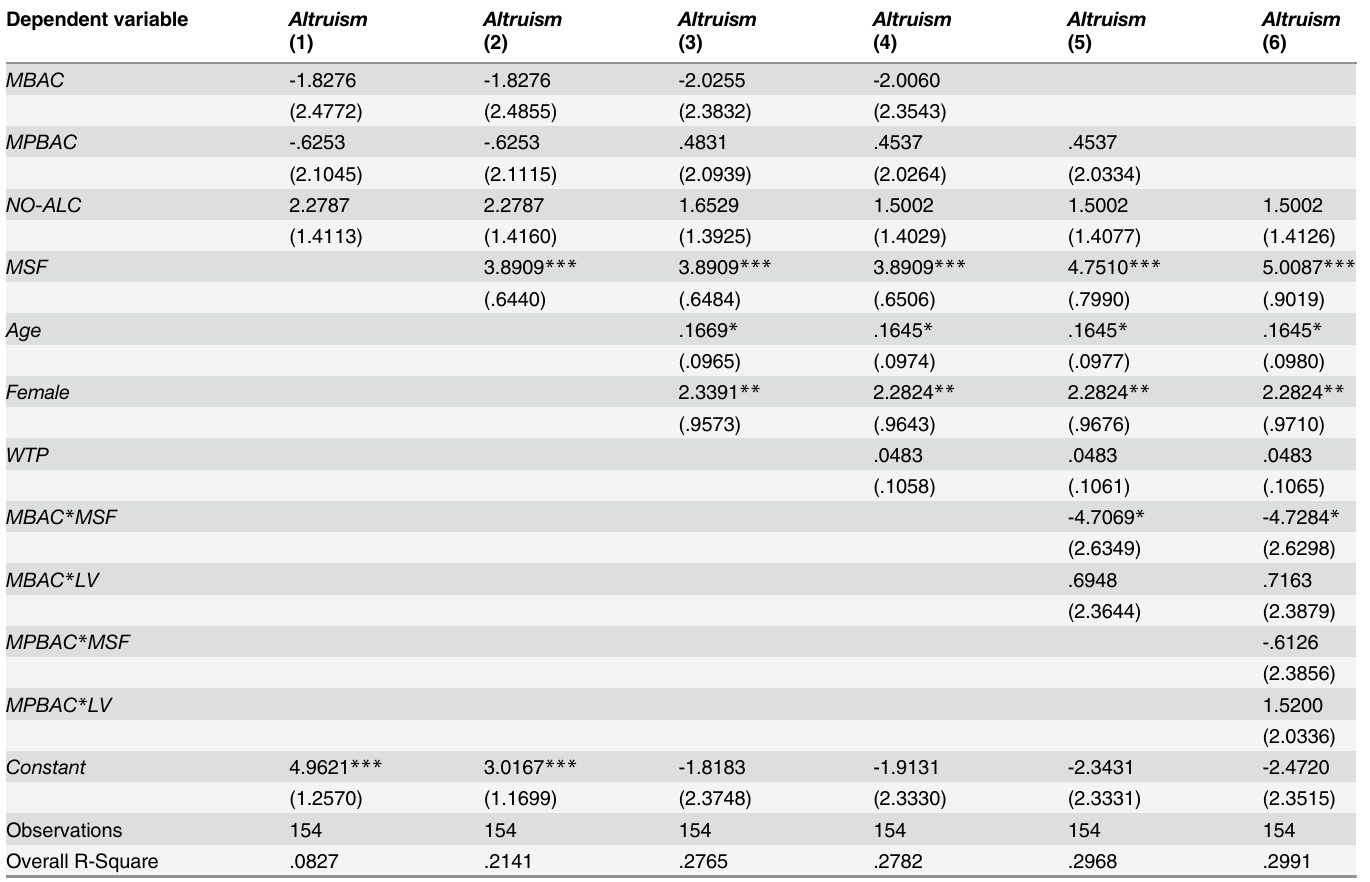
Table 7. Alcohol and Altruistic